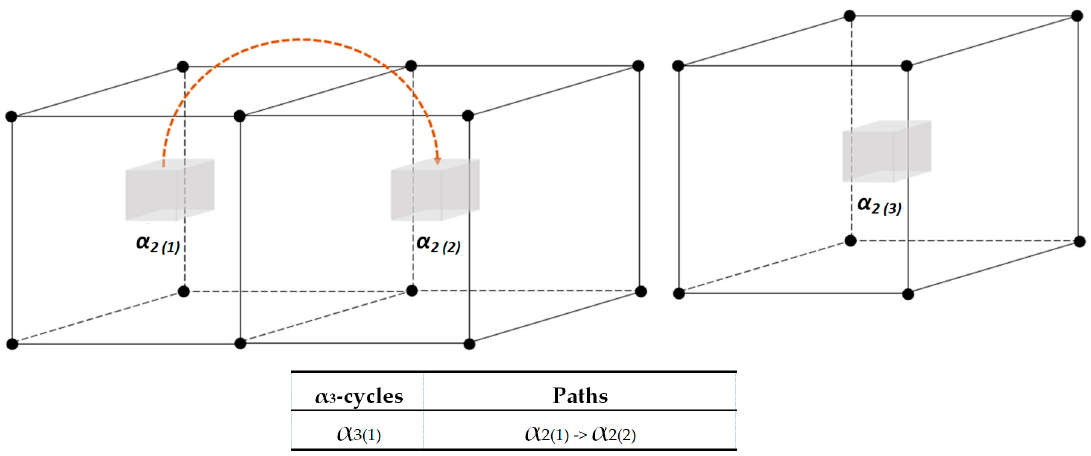
Figure 4. α 3 -cycles and their connectivity.